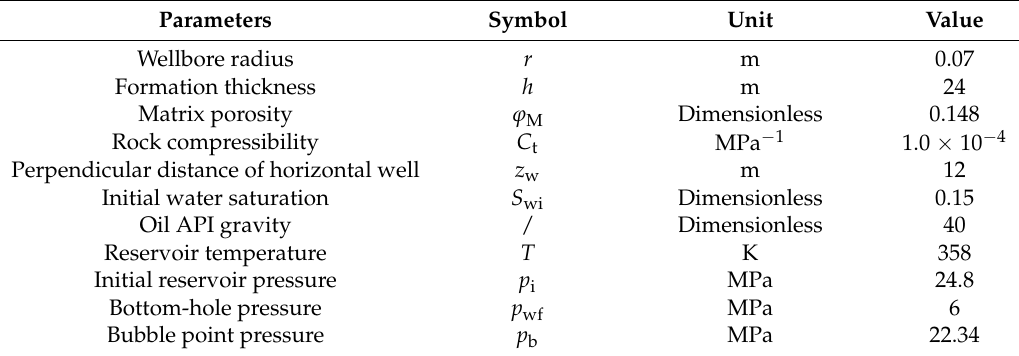
Table 3. Basic input parameters for field case.